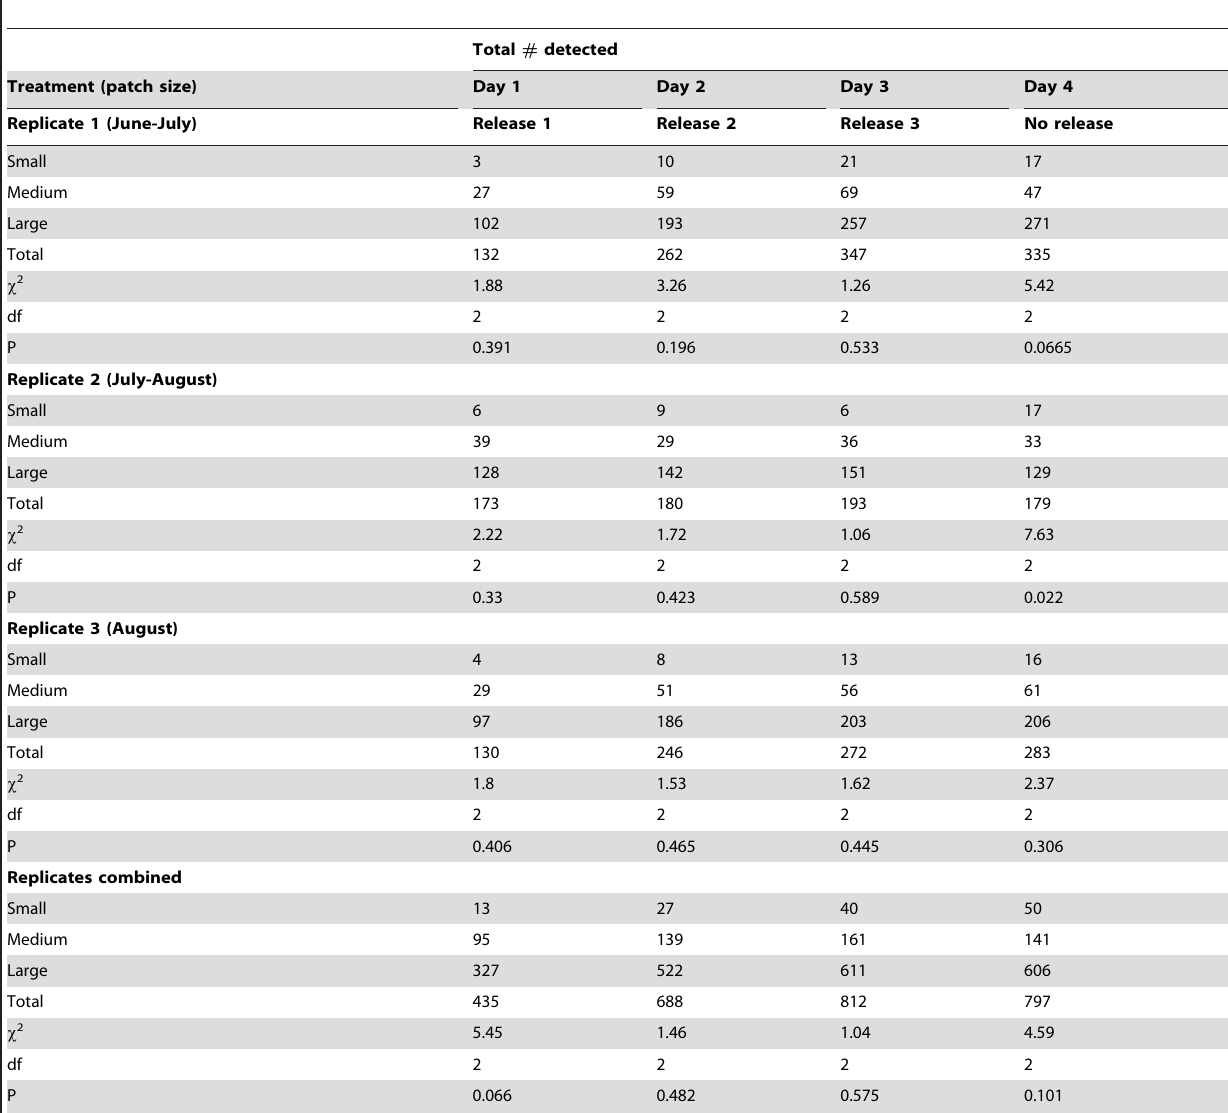
Table 3. Distribution between small, medium and large size patches of potato of the total numbers of tagged beetles detected by radar 1, 2, 3 or 4 days after initial release in three consecutive